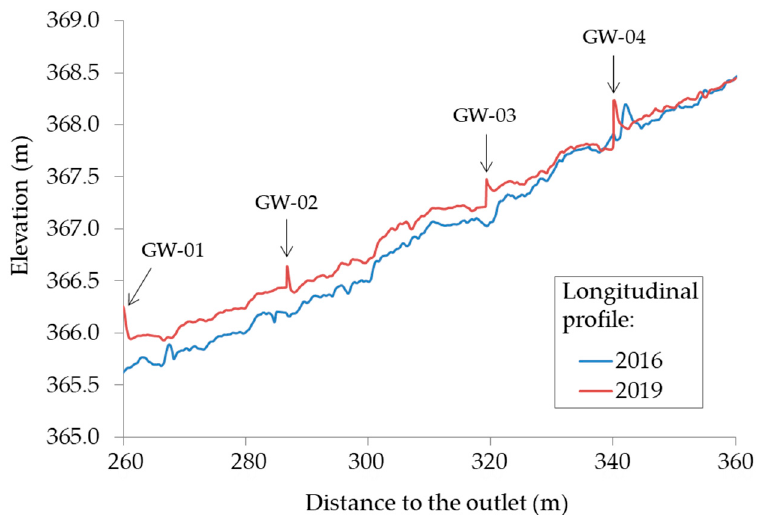
Figure 16. Longitudinal profile of the channel between GW-01 and GW-04. GW = gabion